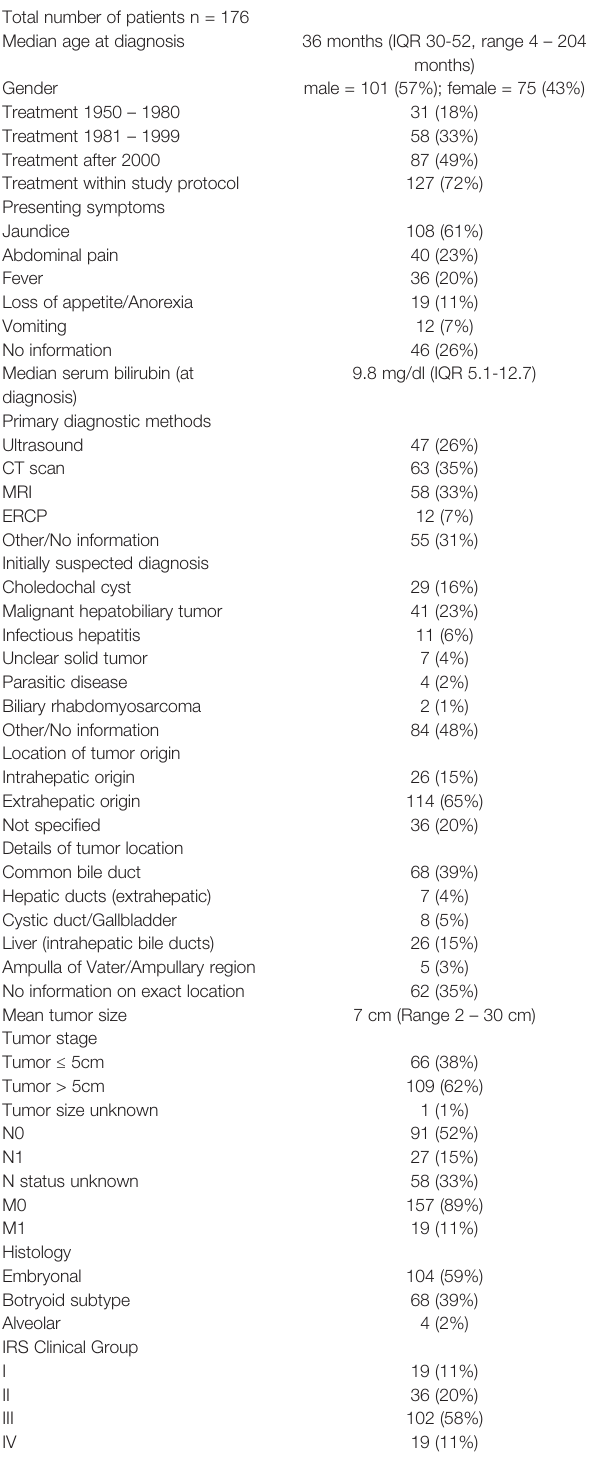
TABLE 1 | Patient